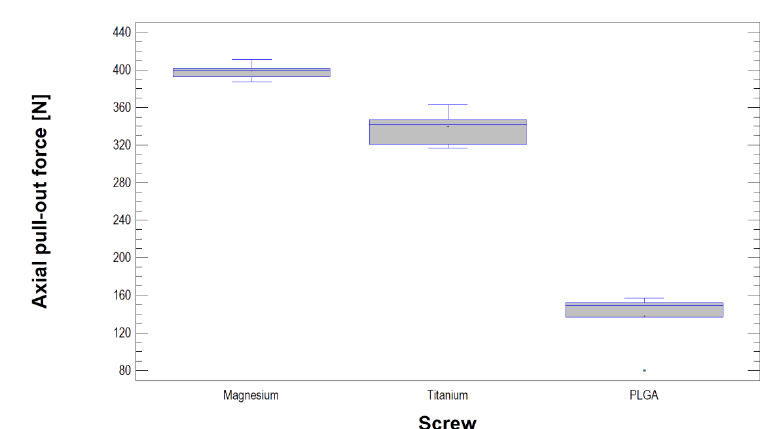
Figure 5. Maximal moment of the torque [N·cm] before the screw was damaged. The magnesium alloy screw is weaker than the titanium alloy screw ( p < 0.05).